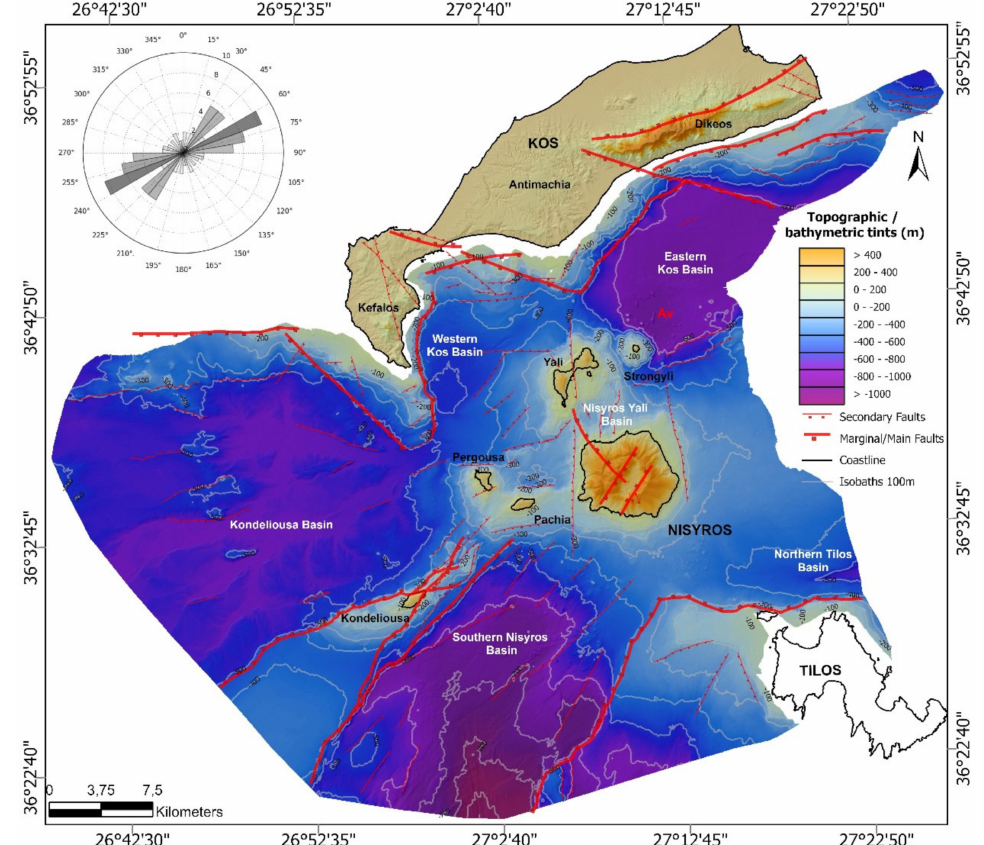
Figure 3. Synthetic topographic and tectonic map of Kos-Nisyros volcanic field based on onshore and offshore data [15,43,49]. In the upper left part of the map a rose diagram is depicting the directions and the frequency values of the faults in the study area. Av: Avyssos submarine